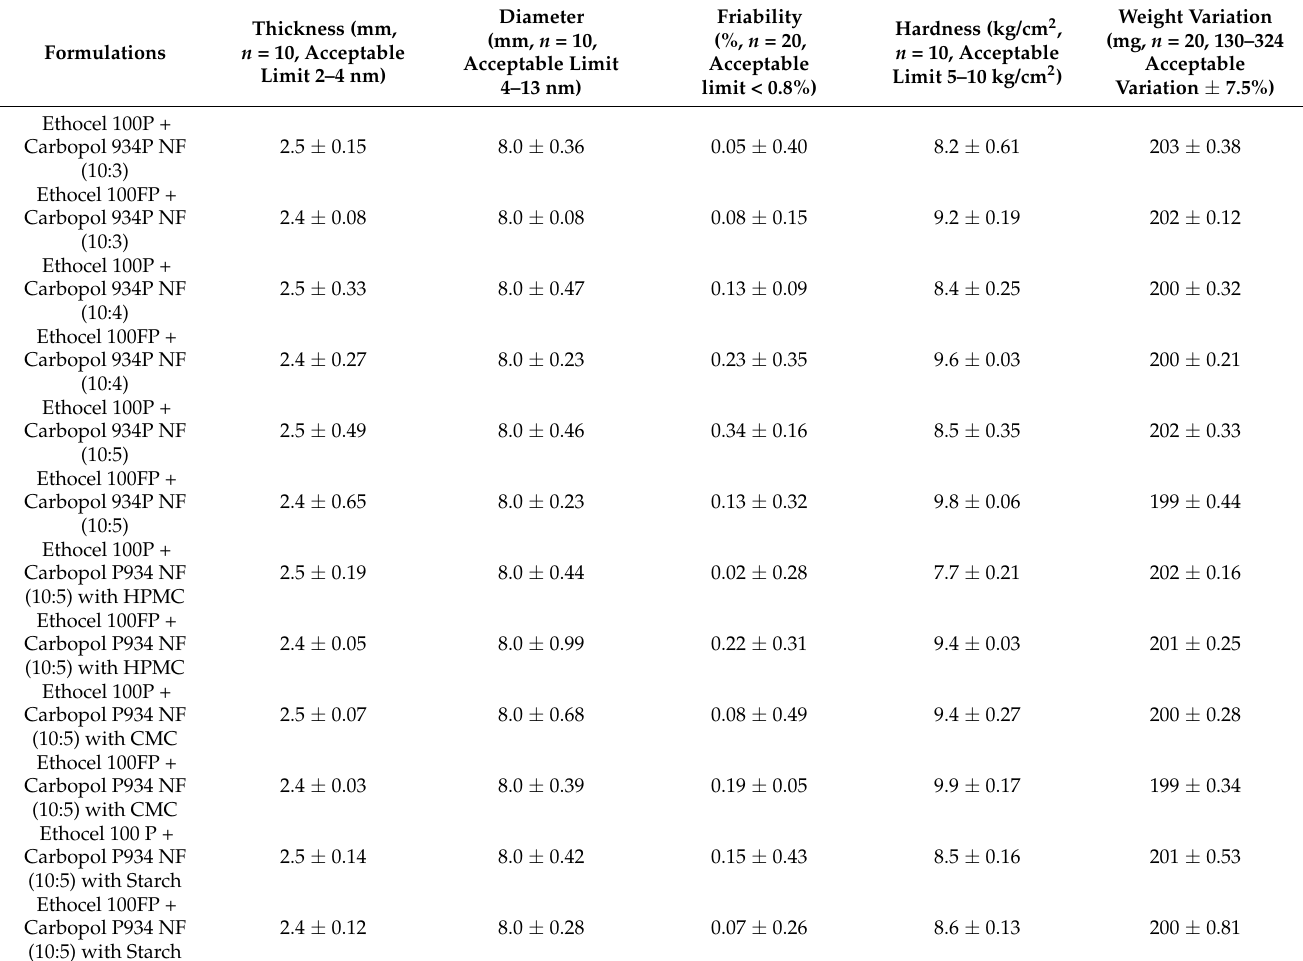
Table 3. Physical